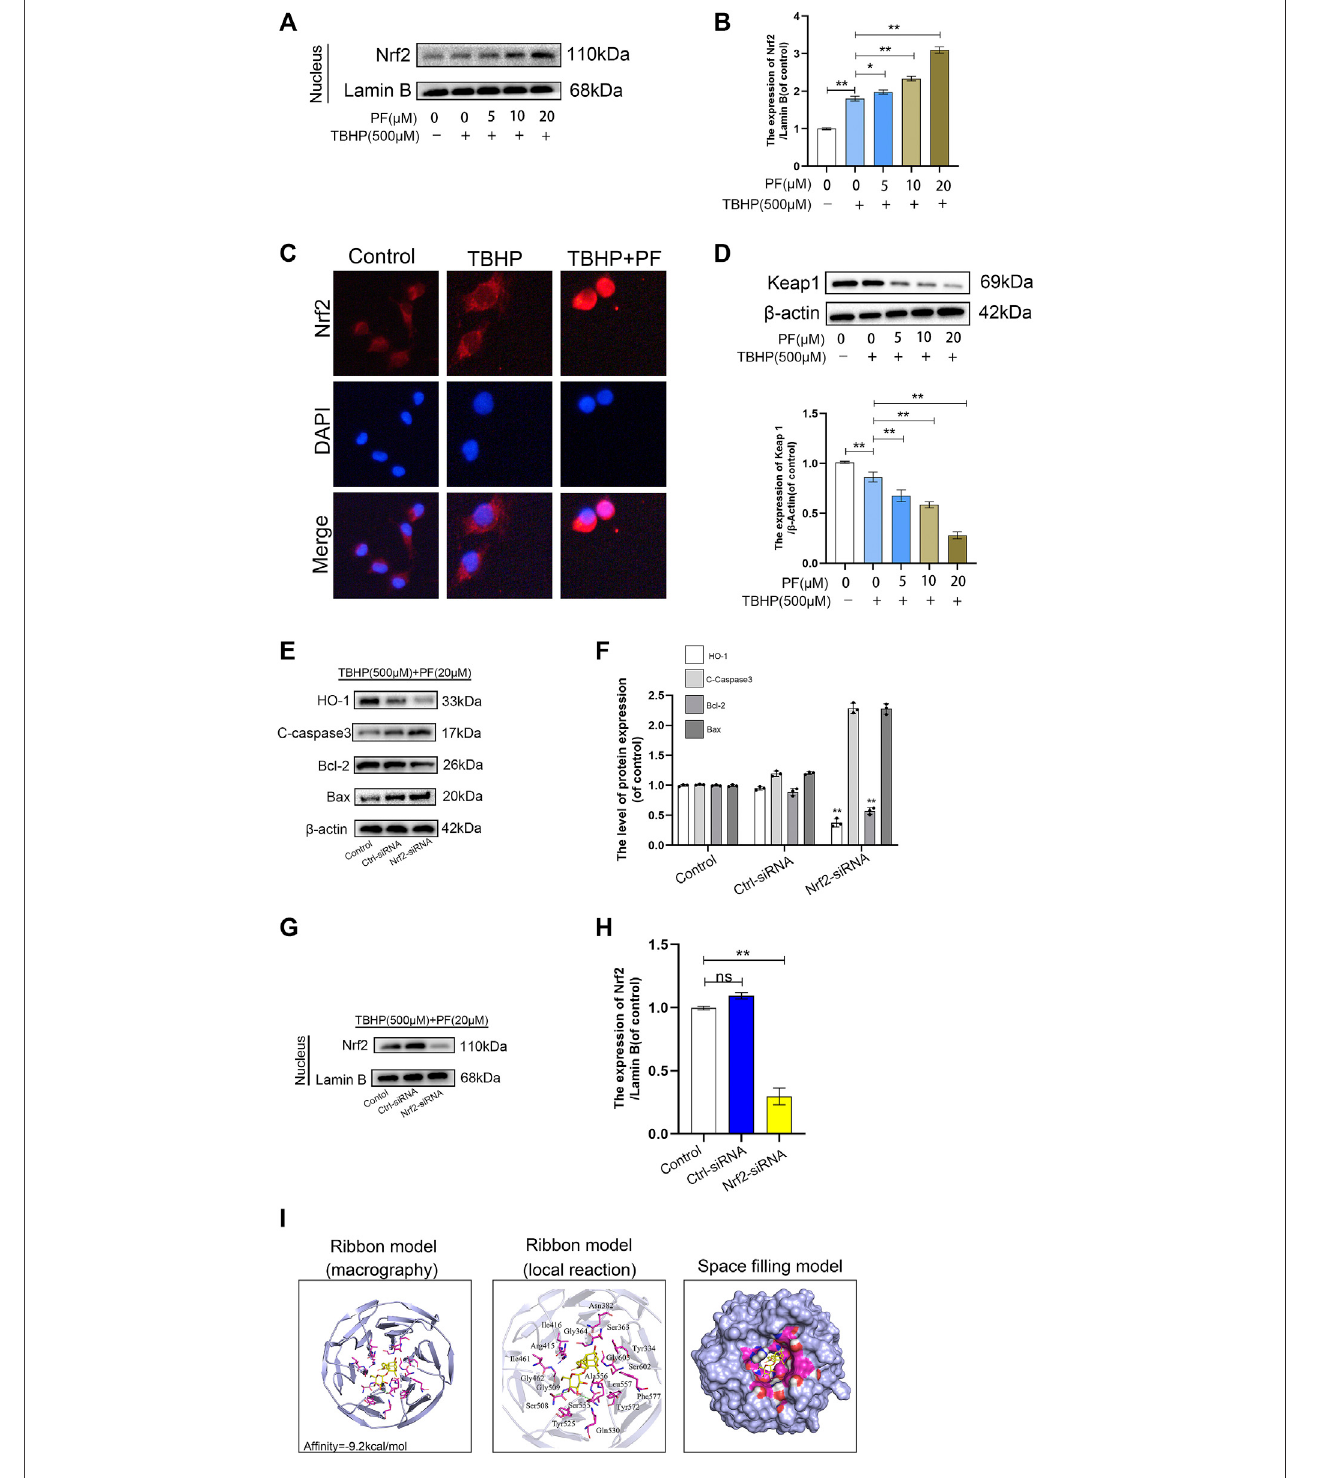
FIGURE6| Paeoni fl orin(PF)-mediatedcytoprotectionviapromotingnucleustranslocationofNrf2andactivatingtheNrf2/HO1signalingpathway. (A,B) Expression of Nrf2 in the nucleus performed in the Western blotting assay and analysis Nrf2 expression in each group administrated as depicted above. (C) Representative immuno fl uorescence images of HUVECs treated with or without PF (20 μ M) for 24 h and 500 μ M TBHP for 2 h showing Nrf2 expression in the HUVECs. Scale bar: 20 μ m. (D) Expression of Keap1 performed in Western blotting assay and analysis Keap1 expression in each group administrated as depicted above. (E – H) After